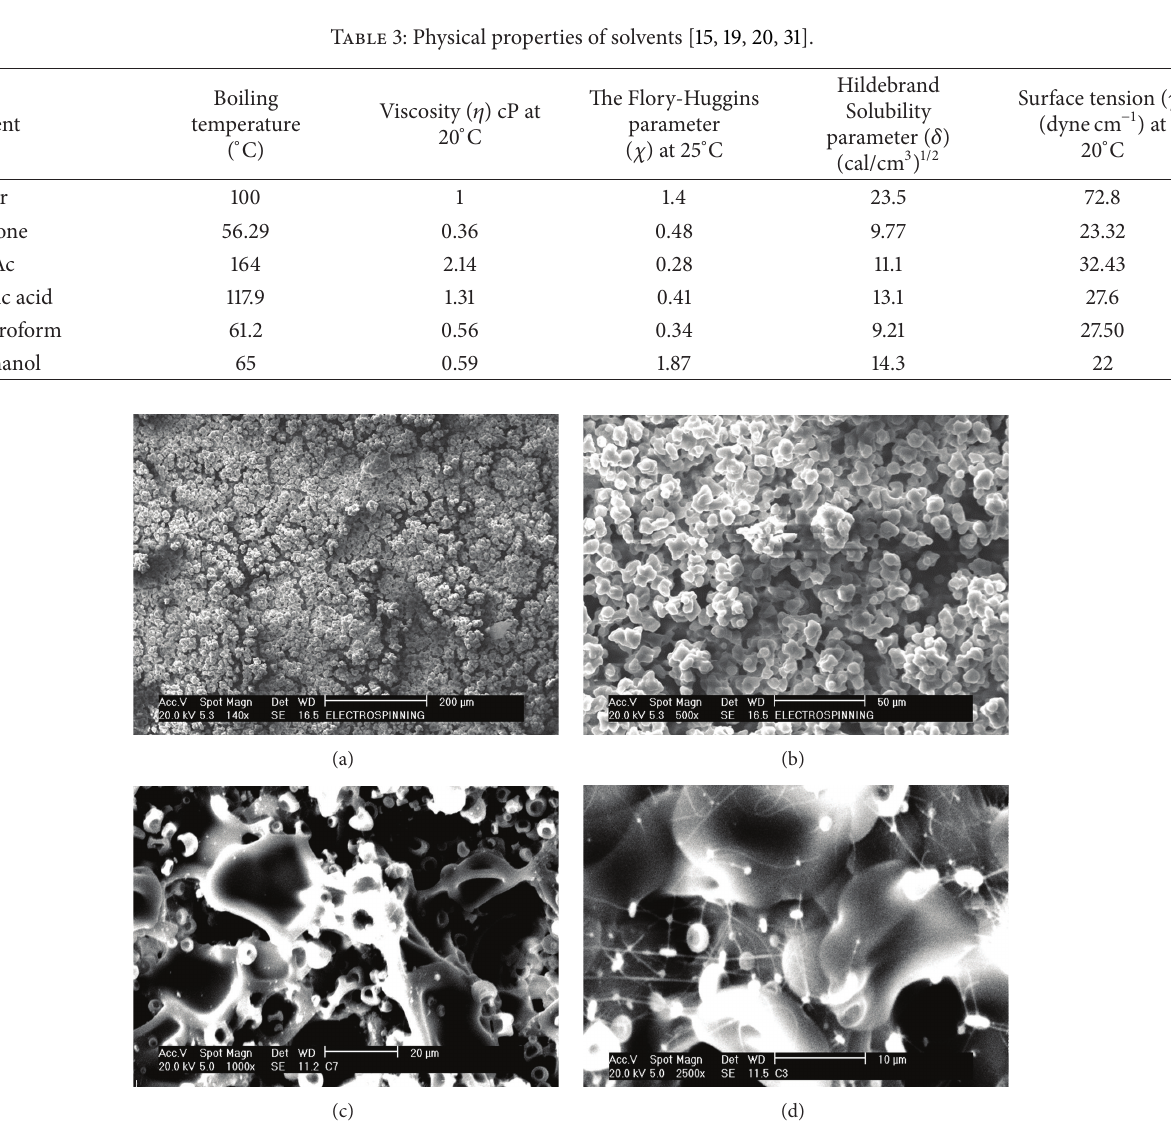
Figure 1: SEM micrographs showing the effect of: (a) chloroform as solvent on resulting CA electrospun fibre morphology, Mag 140x (b) Methanol, Mag 500x, and ((c)-(d)) Acetic acid :water (3: 1) Mag